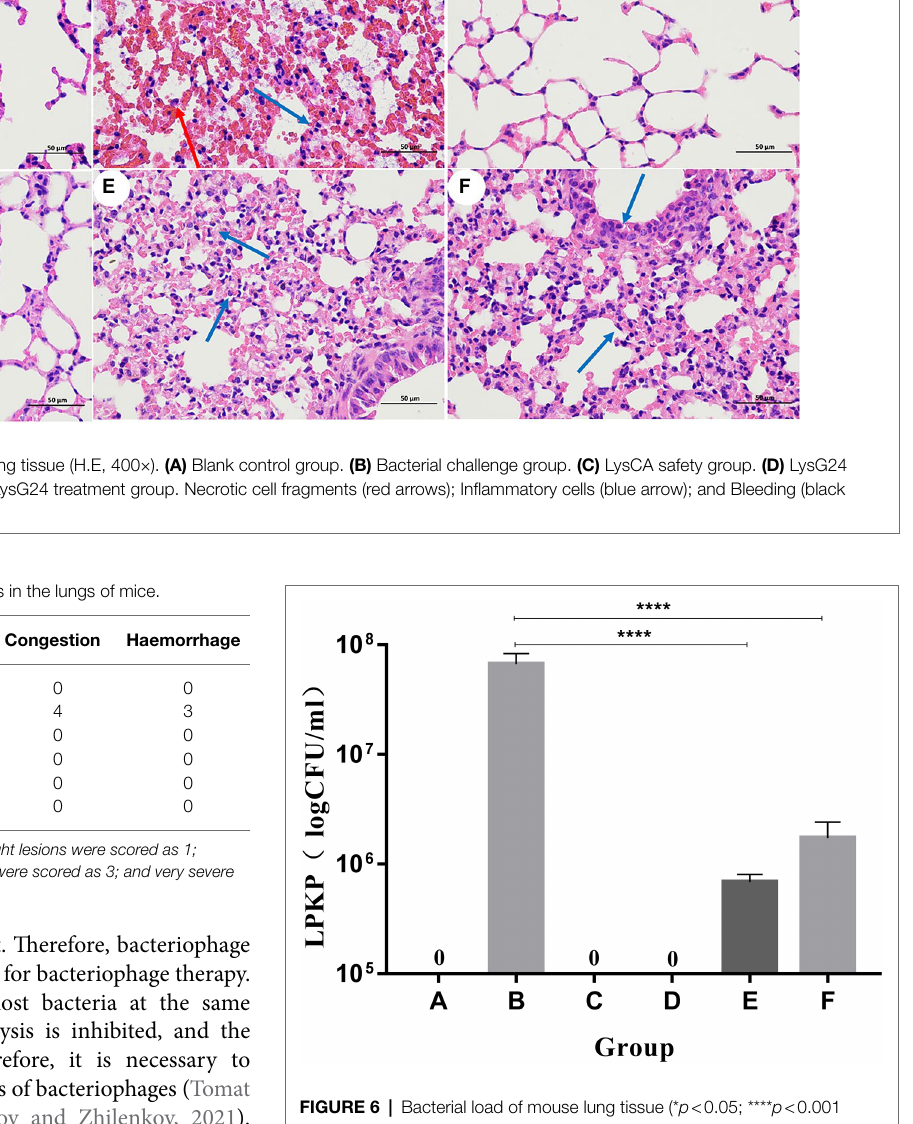
No lesions or very few lesions were scored as 0; slight lesions were scored as 1; moderate lesions were scored as 2; severe lesions were scored as 3; and very severe lesions were scored as